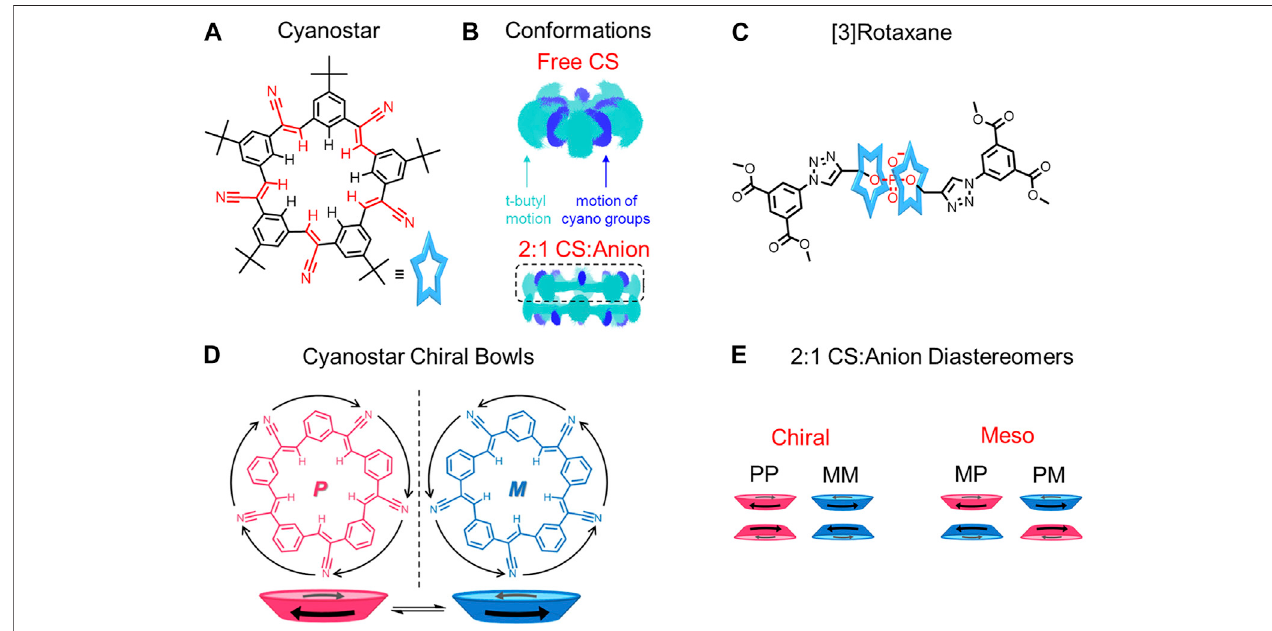
FIGURE10|(A) Cyanostarmacrocycleand (B) representationsofthemoleculardynamics(MD)simulationsshowingthesuperpositionofconformationsofasingle (top) and π -stacked dimer of macrocycles (bottom). The top-most macrocycle of the pair (boxed) de fi nes a shallow bowl. The carbon-hydrogen backbone is shown in cyan blue while the cyano nitrogen atoms are colored dark blue. (C) [3]rotaxane composed of two cyanostars and an organophosphate dumbbell. (D) Top views and cartoon bowl representations of the chiral conformations of cyanostar. (E) Chiral and meso combinations of the cyanostar macrocycle dimers. Adapted with permission from (Liu et al., 2016). Copyright 2016 American Chemical